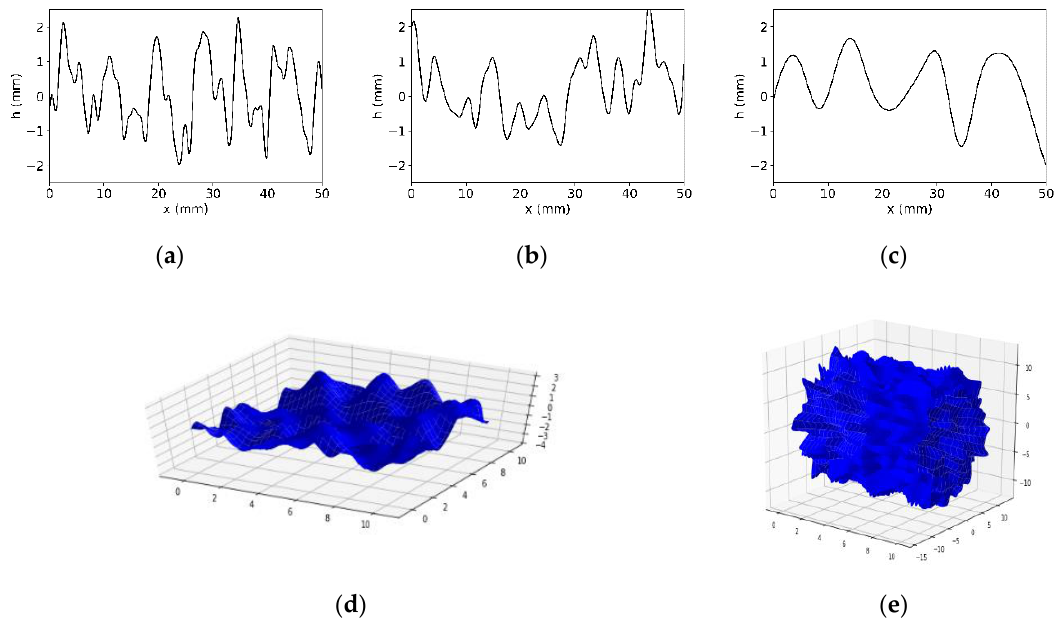
Figure 1. Exaggerated examples of rough surfaces generated for CIVA calculations with standard deviation of the height set to 1 mm for different kinds of rough surfaces: ( a – c ) linear profile for respective ratio L / σ = 1, L / σ = 1.5 (case of Figure 6) and L / σ = 4.3 (case of Figure 11); ( d ) planar for L / σ = 1; ( e ) cylindrical for L / σ = 1. Scales in mm.